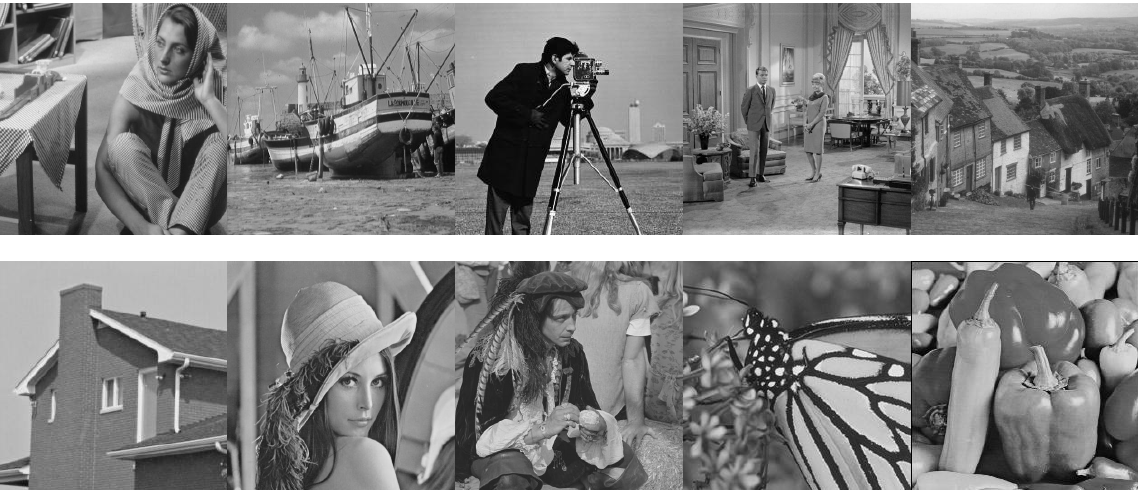
Figure 7. A range of 10 widely-used test images in the